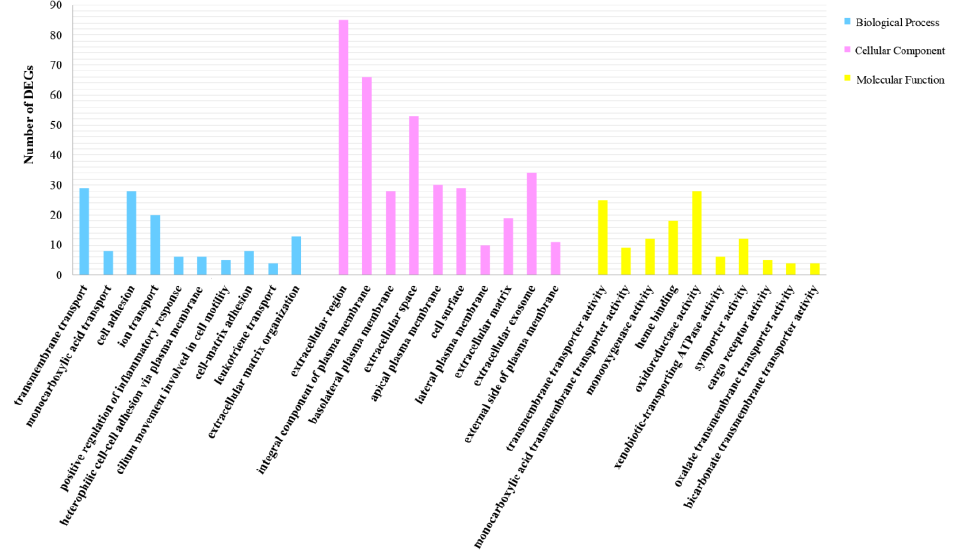
Figure 4. Top 10 significant GO terms. Ordinate indicates DEG numbers; abscissa stands for specific terms.